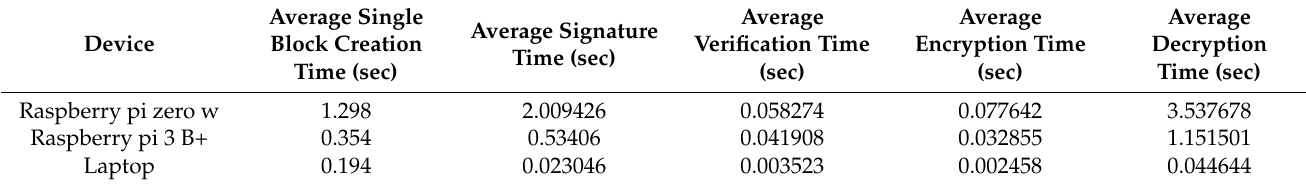
Table 2. Time performance measurements of Authentication-Chains.